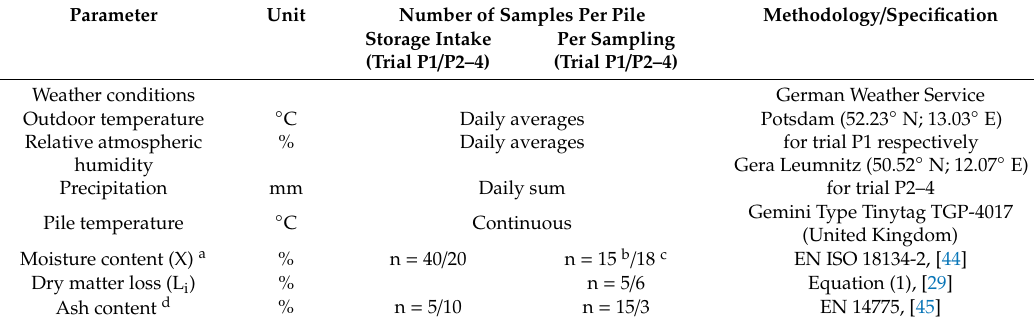
Table 2. Parameters and methods for analyzing tree samples.